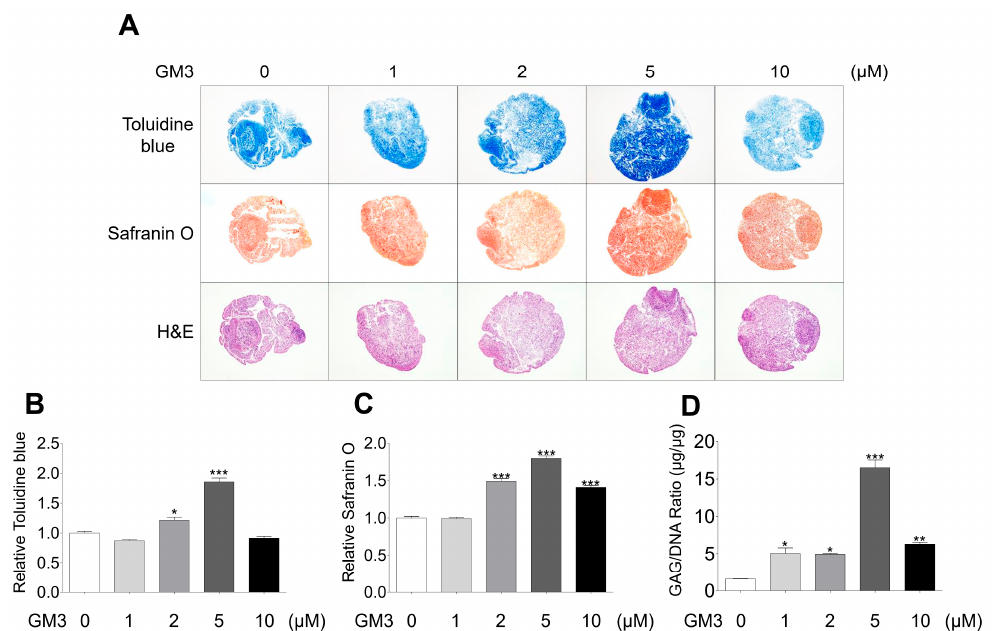
Figure 3. Histological and biochemical analysis of chondrogenically di ff erentiated aggregates. ( A ) Chondrogenically di ff erentiated aggregates from all groups were stained with toluidine blue, safranin O, and hematoxylin and eosin. Relative ( B ) toluidine blue and ( C ) safranin O intensity after chondrogenic di ff erentiation. The values shown are the mean ± SEM from three independent experiments. * p < 0.05 and *** p < 0.001 compared with the 0 µ M GM3 treated group. ( D ) After the di ff erentiation of chondrogenic aggregates, the aggregates were digested with papain, and sulfated glycosaminoglycans and DNA content were measured. Glycosaminoglycan content was normalized to total DNA content for each sample. The values shown are the mean ± SEM from three independent experiments. * p < 0.05, ** p < 0.01 and *** p < 0.001 compared with the 0 µ M GM3 treated